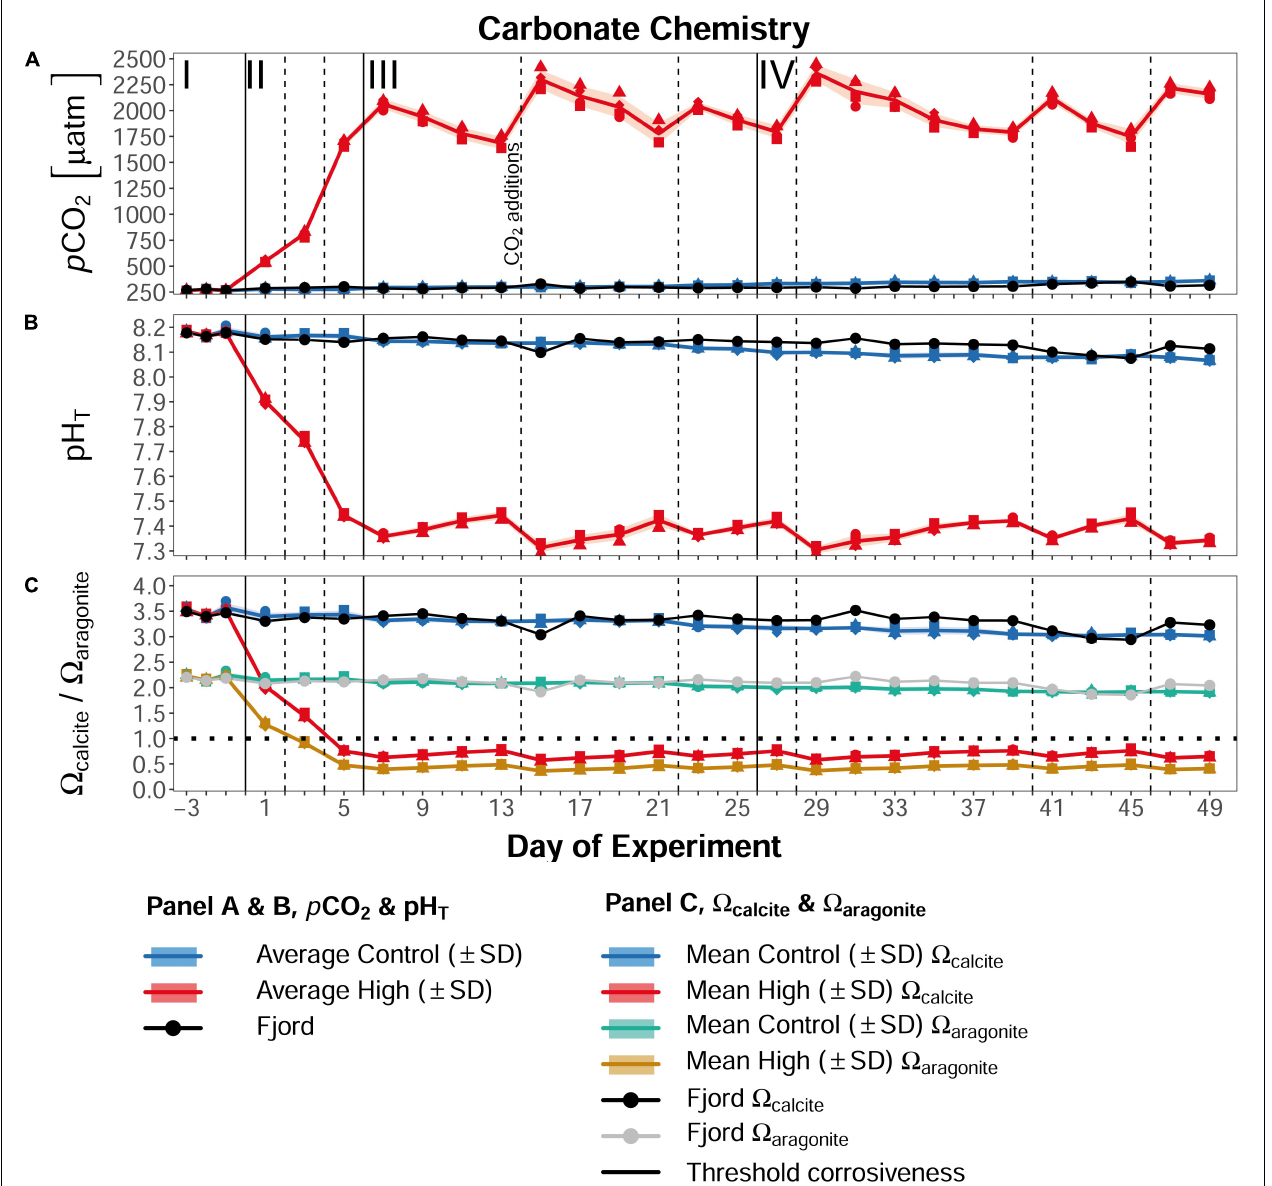
FIGURE 6 | Overview of the carbonate system parameters. (A) Development of the partial pressure of CO 2 in µ atm, (B) the pH on the total scale (pH T ), and (C) (cid:127) calcite (blue and red lines) and (cid:127) aragonite (green and yellow lines) over the course of the experiment. Lines, symbols, and colors are used as described in Figure 4 . Dashed lines indicate CO 2 additions as shown in Figure 2 , and described in section “CO 2 Addition.” Roman numerals label the different phases of the experiment separated by vertical lines (for description of phases see Table 2 ). Figure created with the ggplot2 package in RStudio (Rstudio Team, 2016; Wickham et al.,